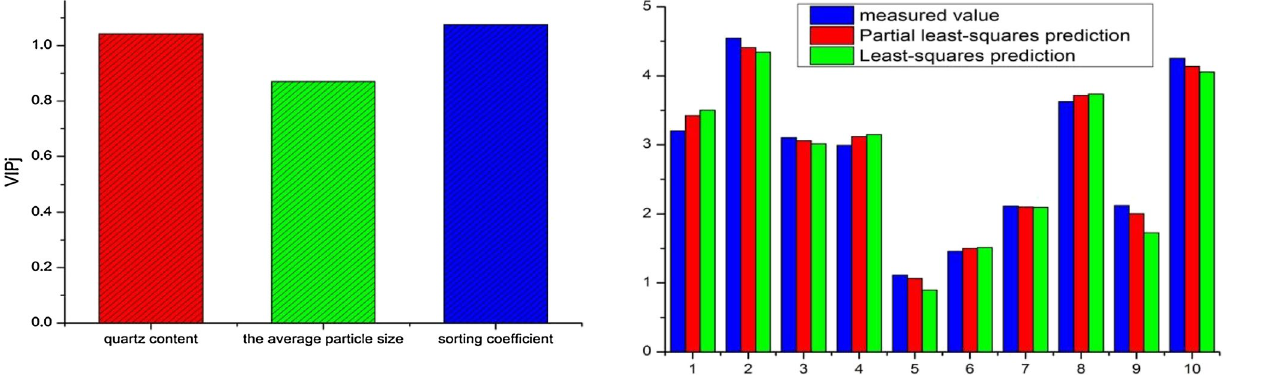
Fig. 12 Partial least squares regression fitting